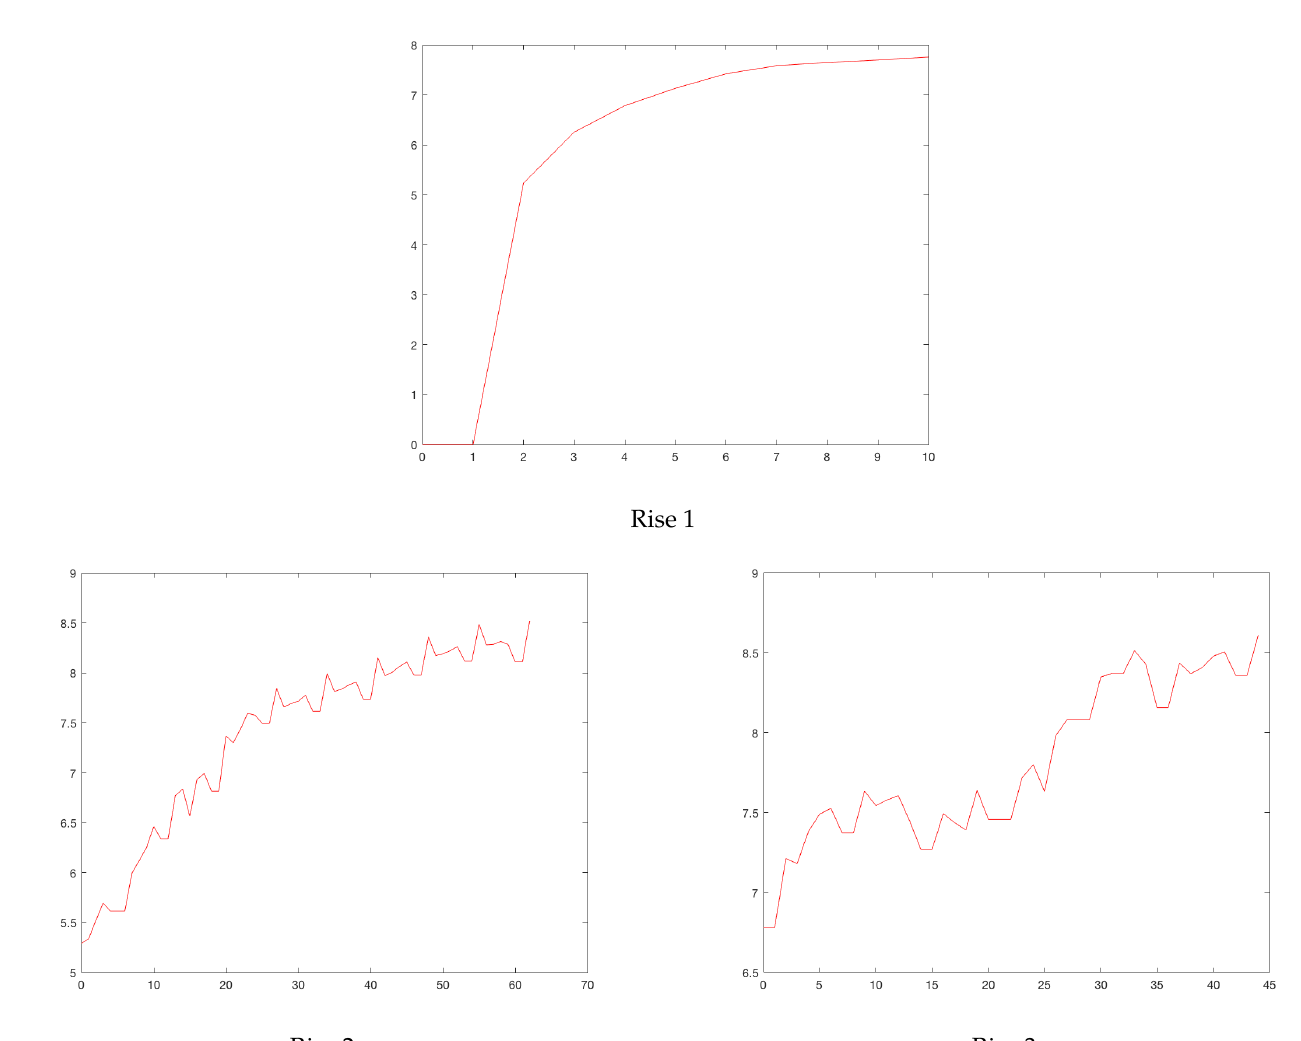
Figure A13. Madrid’s rises. Horizontal axis, days; vertical axis: logarithm of daily cases.